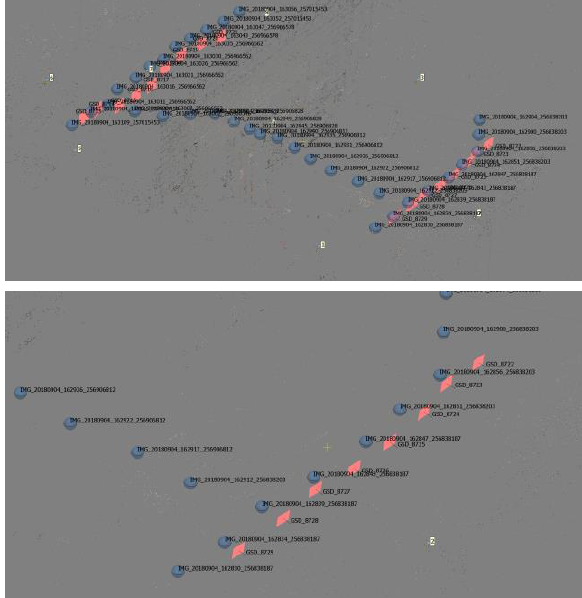
Figure 4. Image coordinates residual after bundle adjustment. A systematic effect in the overlapping area between front- and rear-facing images is clearly visible. Figure 5. Image orientation results for central perspectives and 360° images in the two rooms (top), and a detail for only the second room (bottom).